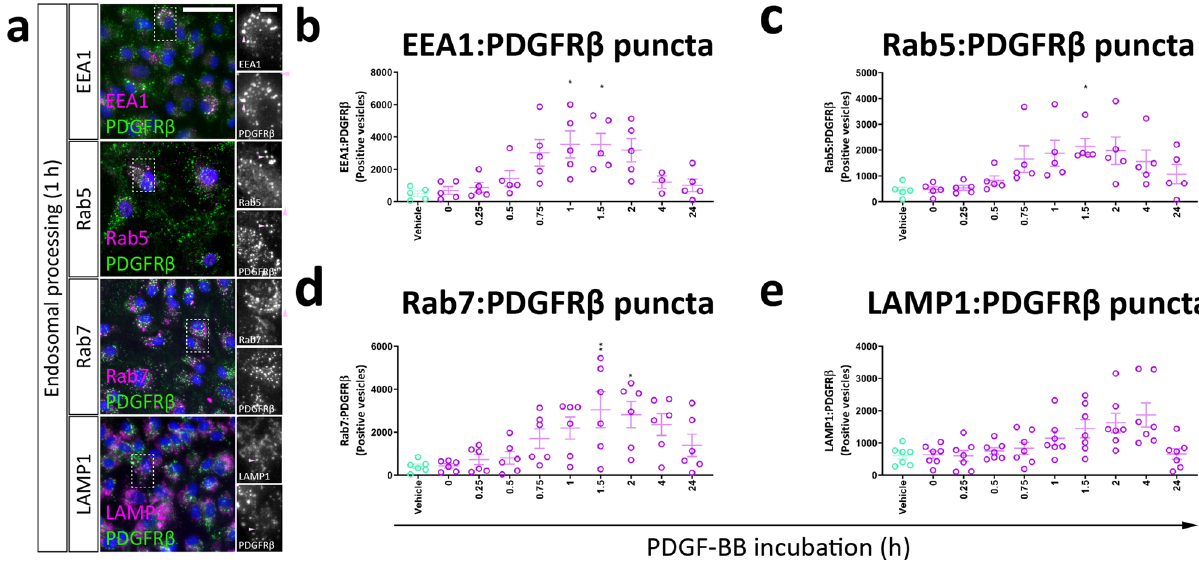
Fig. 4 PDGF-BB causes PDGFR β degradation through lysosomal processing in pericytes. Brain pericytes were treated with PDGF-BB (10 ng/mL) for different lengths of time, then fi xed and stained for endo/lysosomal markers. a Representative images of PDGFR β colabelling with EEA1, Rab5, Rab7 and LAMP1. Scale bar = 50 μ m, inset = 10 μ m. Quanti fi cation of PDGFR β puncta colocalised with b EEA1, c Rab5, d Rab7 and e LAMP1. n = 5, one-way ANOVA. * p < 0.05, ** p < 0.01, *** p < 0.001 vs vehicle control, # p < 0.05, ## p < 0.01, ### p < 0.001 vs